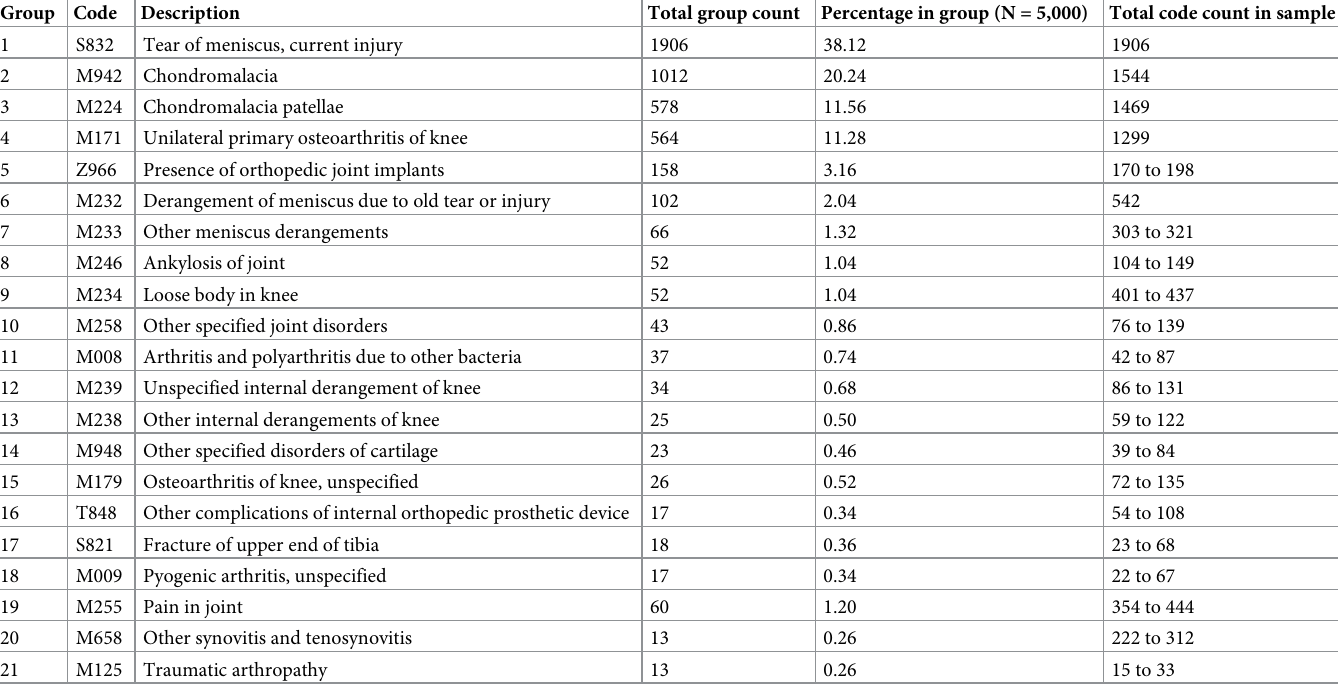
Table 3. Top 21 of 132 diagnosis codes for carrier claims with a knee arthroscopy procedure (CPT 29877), ordered by relative importance from the classification model. Group Code